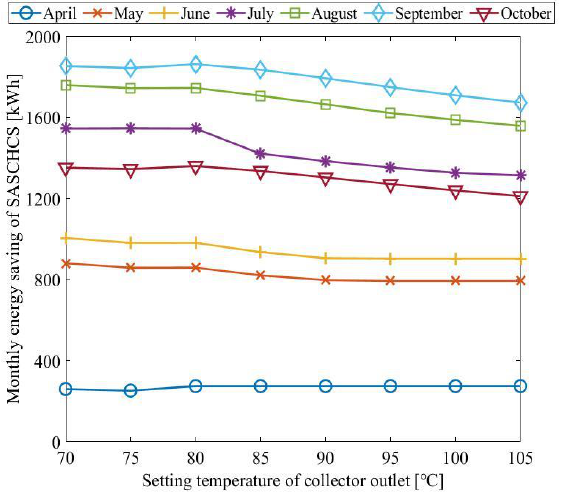
Figure 13. Energy saving for different collector setting temperatures.